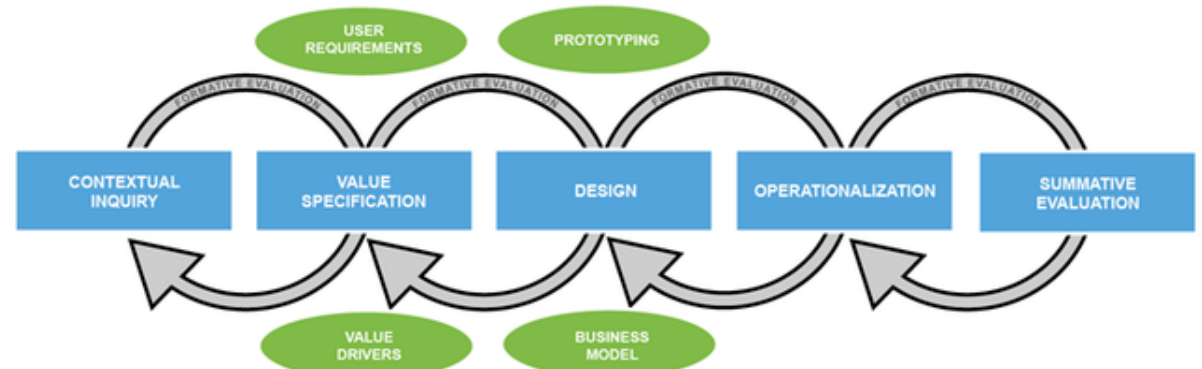
Figure 1. CeHRes roadmap. CeHRes: Center for eHealth